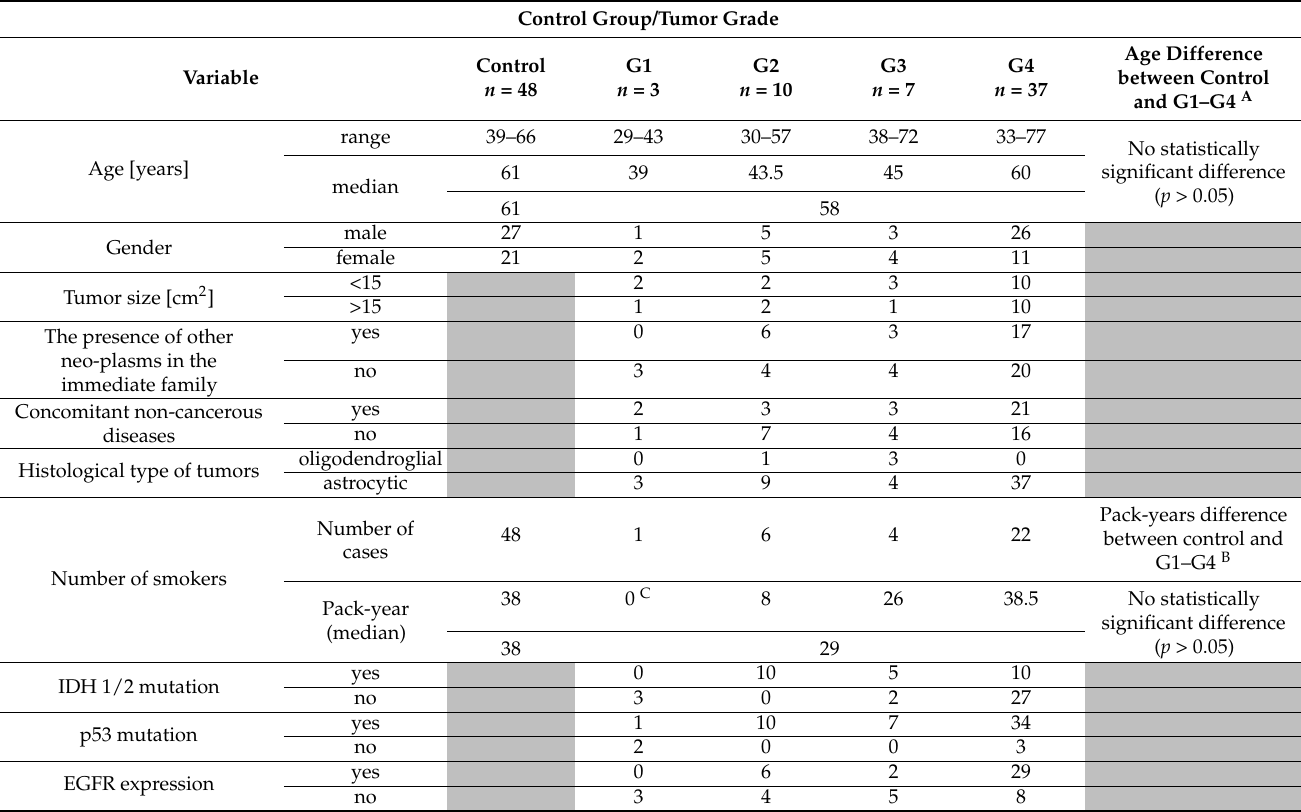
Table 1. Clinicopathological characteristics of